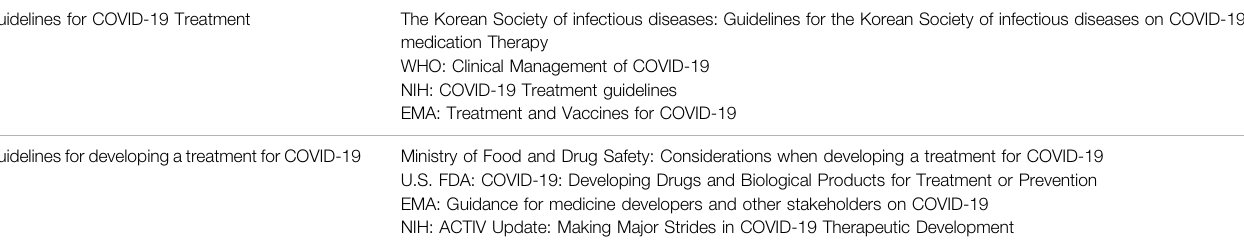
TABLE 1 | Lists of domestic and international guidelines for COVID-19 treatment and therapeutic development. Guidelines for COVID-19